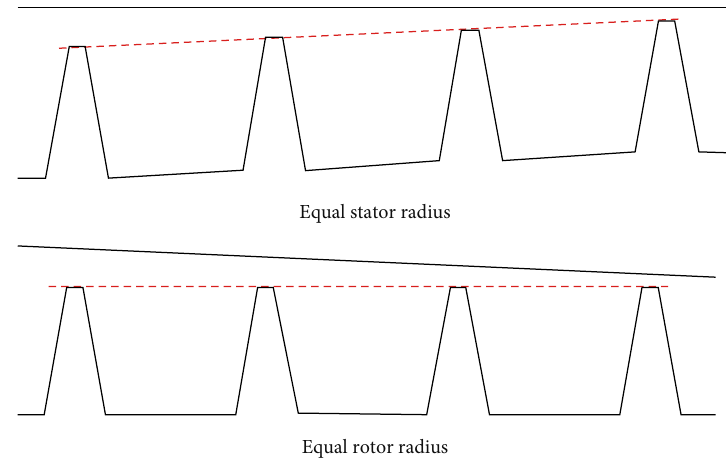
Figure 7: Convergent type clearances caused by rotor deformation and stator deformation.